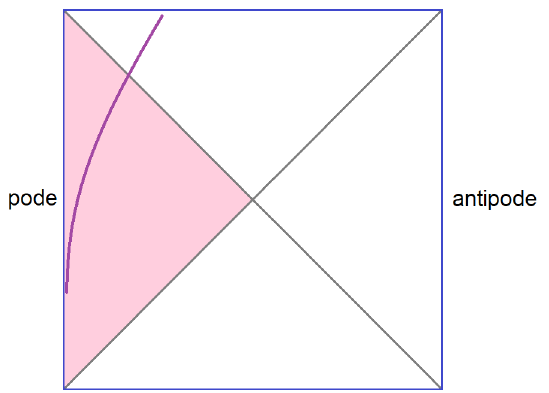
Figure 9. The pode is a point of instability. A particle arbitrarily close to the pode will depart (exponentially) from the pode, and will eventually fall through the horizon. Classically, it will take a logarithmically infinite coordinate time to reach the